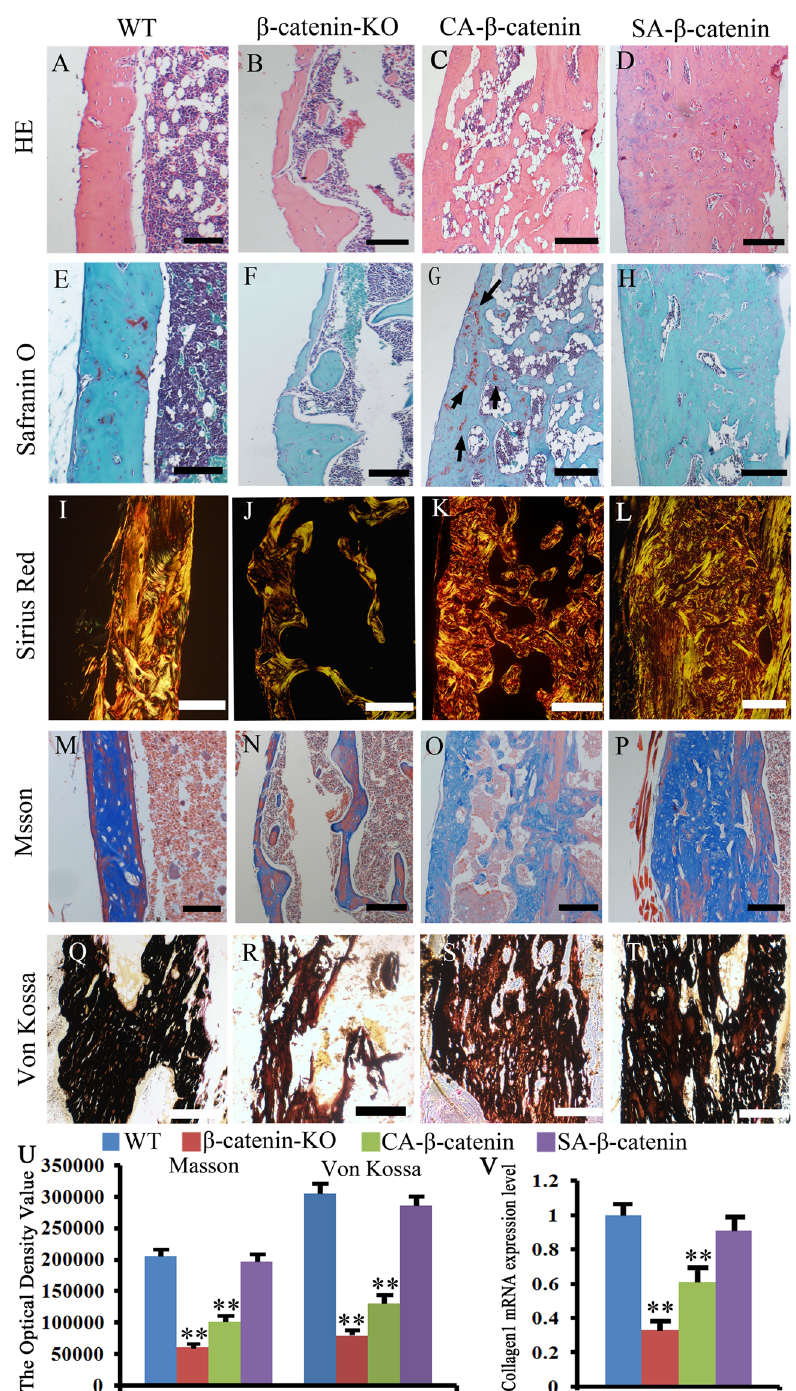
Figure 3. Histological examination revealed that SA- β -catenin mice have better histological morphology at week 8 post-fracture. ( A – D ) Representative HE staining of the fracture site in WT, β -catenin-KO, CA- β -catenin and SA- β -catenin mice. ( E – H ) Representative Fast Green/Safranin O staining images of the fracture site in each group. ( I – L ) Representative sirius red staining images of the fracture site in each group. ( M – P ) Representative Masson staining images of the fracture site in each group. ( Q – T ) Representative Von Kossa staining images of the fracture site in each group. ( U ) The optical density of Masson staining and Von Kossa staining images of the fracture site in each group. ( V ) mRNA expression level of collagen I at the fracture site in each group. The values are expressed as the means ± SDs. * p < 0.05, ** p < 0.01. (arrows in G : the cartilage matrix, Scale bar = 100 µ m in A–H and M–P , 50 µ m in I–L and Q–T , n =